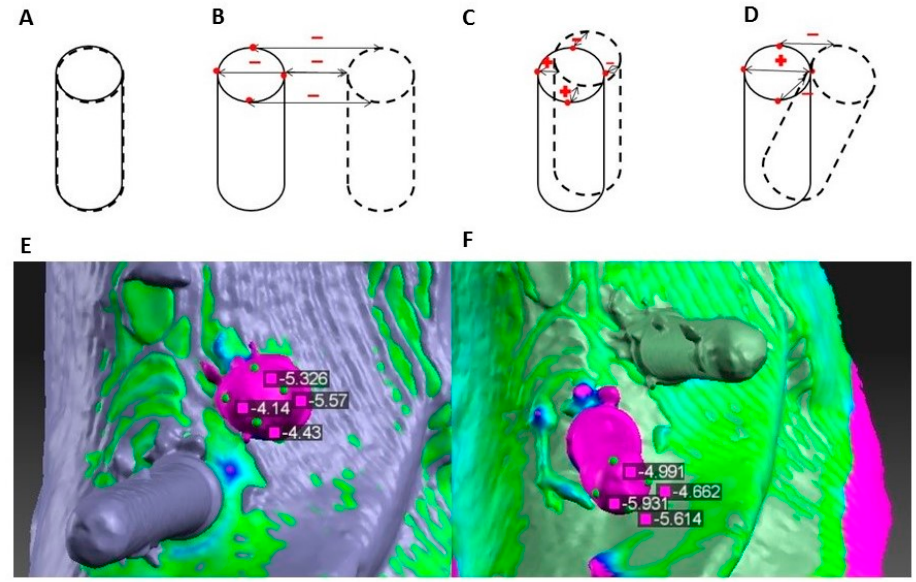
Figure 2. The method of measurement. The continuous line represents the reference model and the dotted line represents the test model. Reference points are marked by red dots. ( A ) Guide pins on both models are in the same place—deviations are equal to 0 mm. ( B ) Guide pin on the test model is implemented beside the guide pin on the reference model—all deviations on reference points are minus. C. and D. Guide pin on the test model is slightly moved ( C ) or implantation angle is different ( D )—deviations on the reference points are plus or minus depending on whether the nearest surface of the test model is covered by the reference model or not. ( E ) Deviation on model number 4 in comparison with model number 5 (5 vs. 4). ( F ) Deviation on model number 5 in comparison with model number 4 (4 vs. 5).